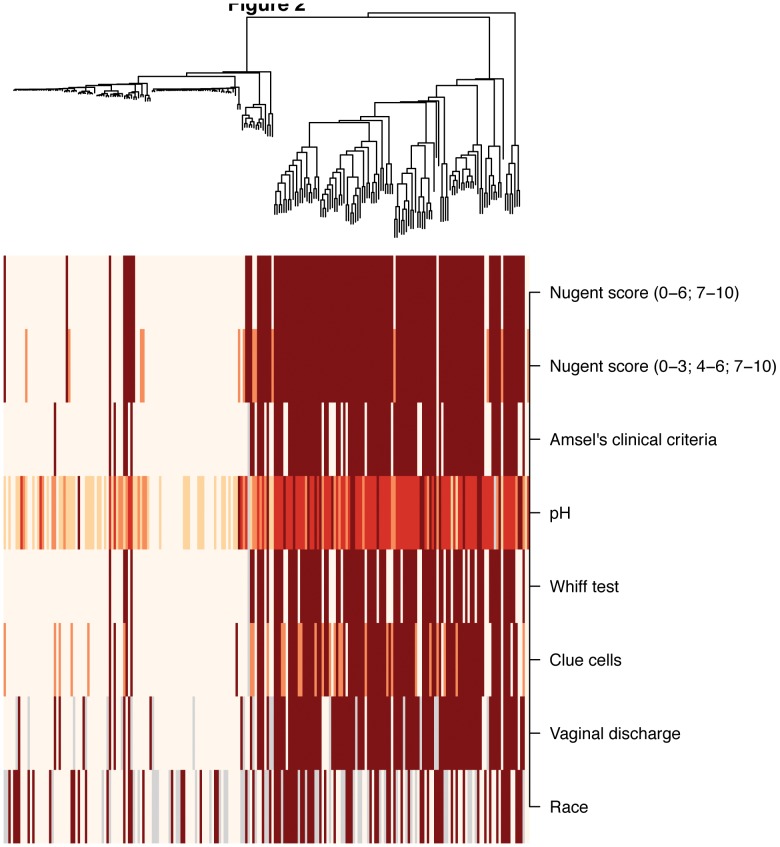
Association of vaginal bacterial communities with BV status, clinical features and race.A dendrogram shows association of meta data with vaginal bacterial communities. Nugent score and Amsel’s clinical criteria for BV are expressed as negative (light) and positive (dark). Nugent scores are presented in 2 formats, one considering BV positive (7–10) vs. BV negative (0–6), and the other separating data on women with intermediate scores (4–6) indicated in orange vs. women without BV (0–3) in white). pH values range from 4 to 6. Numerical values are shaded from light (low) to dark (high). Whiff test is expressed as positive (dark) or negative (light) and abundance of clue cells is expressed as none, <20%, and >20% (light to dark). Vaginal discharge is represented as normal (light) and abnormal (dark). The race band denotes white (light) and black (dark) women. Gray bars denote that data not available or do not fit the criteria outlined. Meta data are also available in Table S3.